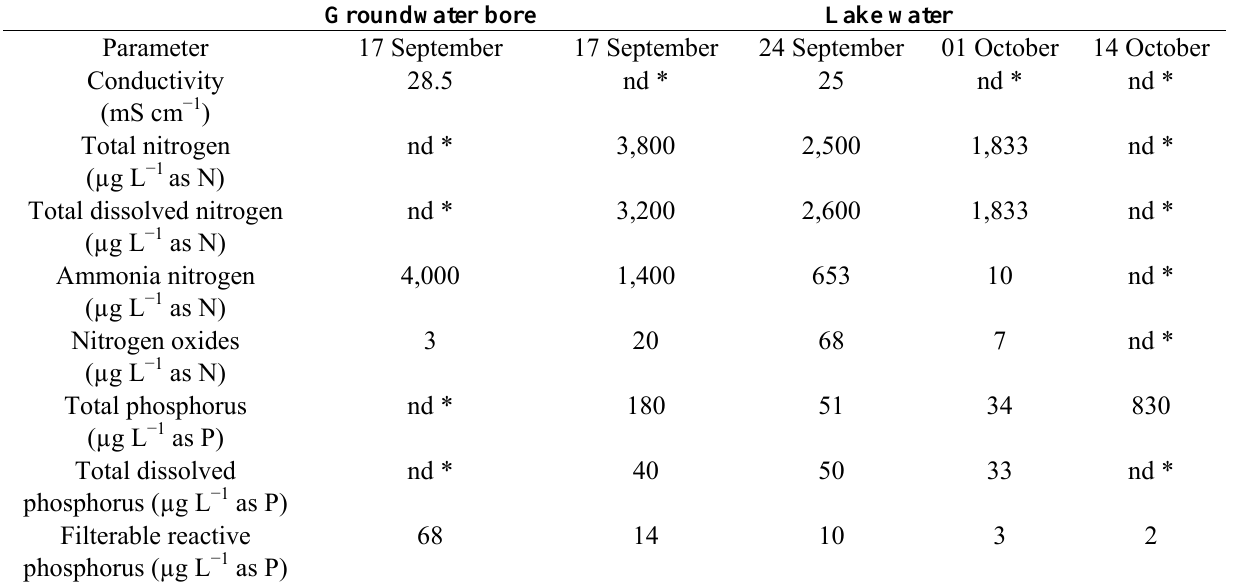
Table 1. Mean physico-chemical characteristics of Carbrook Cable Ski Lake during the period September–October